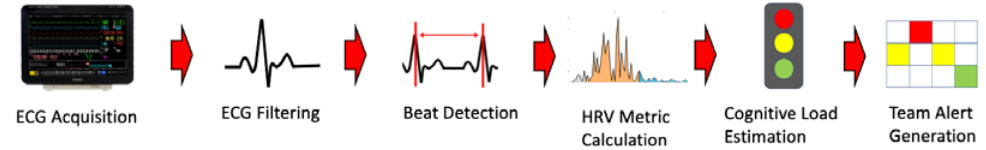
Figure 2. Stages of the Processing Pipeline .